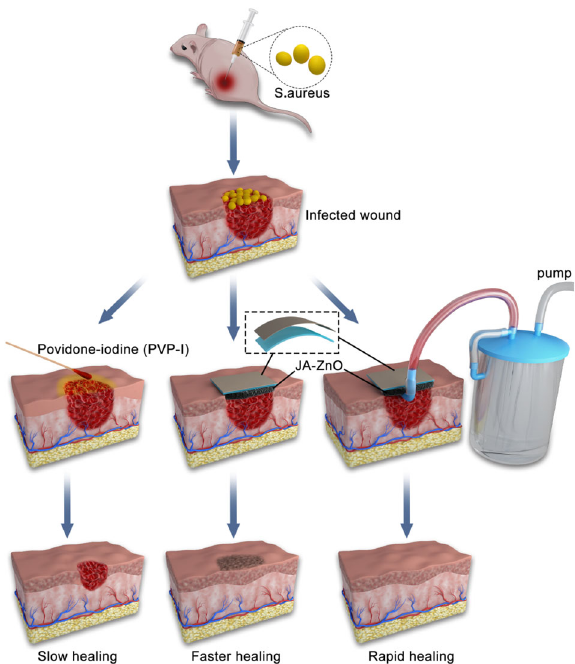
Fig. 5 Mechanism diagram of povidone-iodine (PVP-I), ZnO/JFA, and ZnO/JFA with VSD treatment in evaluating the healing process of infected skin wounds in